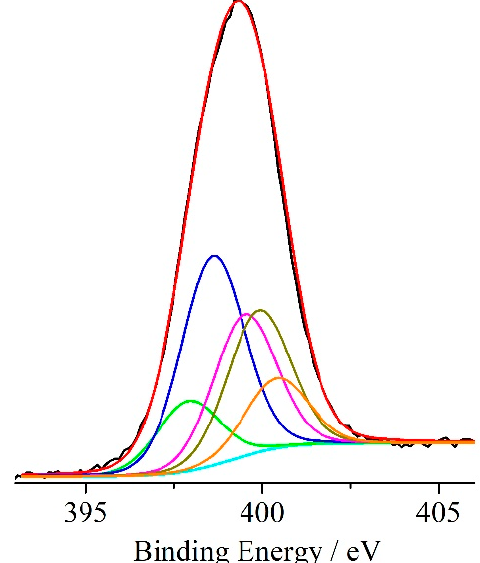
Figure 6. Al-K α excited XPS of the Au NPs–porphyrin system in the N 1s binding energy region. The orange, dark yellow, magenta, blue, and green lines refer to the 400.4, 399.9, 399.5, 398.6, and 397.9 eV components; the cyan line refers to the background and the red line superimposed on the experimental black profile refers to the sum of all Gaussian